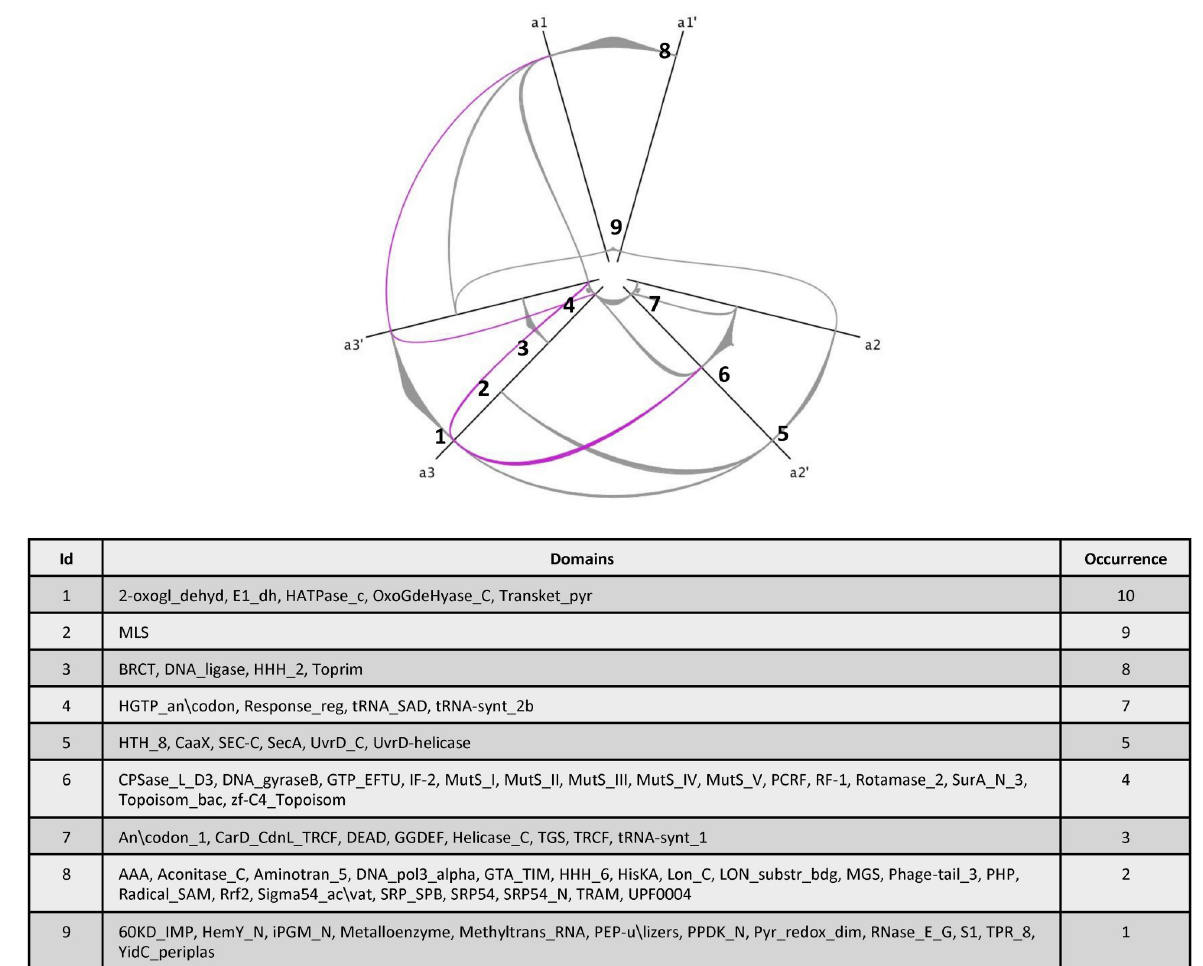
Fig 8. Protein architecture network of putative effectors for rarely occurring domains. This network of pT4E protein architectures was drawn using the hive plot algorithm to produce a rational visualization method based only on the network structural properties. Each node represents a specific domain or a list of specific domains (see table) found in Ehrlichia T4Es predicted by S4TE 2.0. Links between domains represents the association between these domains in the architecture of Ehrlichia pT4Es. Nodes representing the most abundant domains presented in Fig 7 (NLS, Coiled-coils, EPIYA and E block domains) and their corresponding links to other nodes are not included in this graph to highlight the less abundant protein domains in Ehrlichia spp predicted T4 effectomes. The table of domains identifies the protein domains for each node (numbered) and their occurrences. All the domains are ranked on the three axes (a1, a2, a3) according to the number of their links. Let X be the number of links between one domain and the others, X < 3 was represented on axis a1, 3 � X � 5 was represented on axis a2, and X > 5 was represented on axis